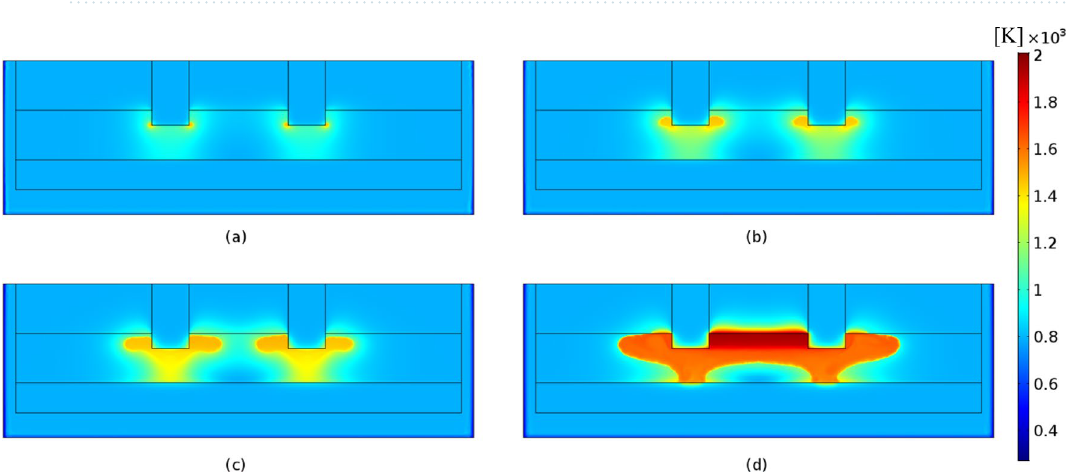
Figure 7. Temperature distribution (K × 10 3 ) in the SAF at times equal to ( a ) 2500 s, ( b ) 5000 s, ( c ) 7500 s and ( d ) 10,000 s. A direct pathway from the immersed electrode tip to the ferronickel region is observed which can be defined as the submerged arc occurring in the SAFs.